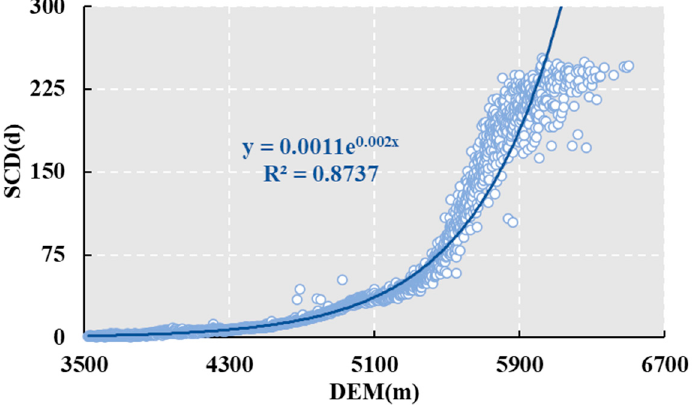
Figure 9. Correlation between DEM and SCD.